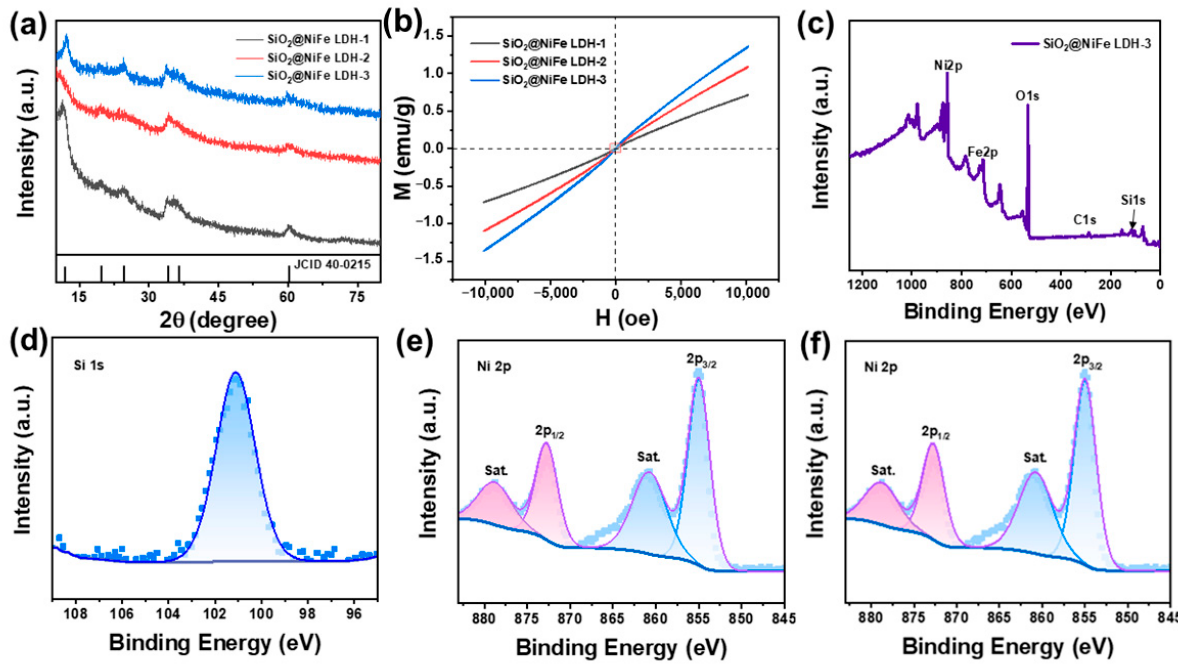
Figure 2. ( a ) XRD patterns, ( b ) magnetic hysteresis loops of SiO 2 @NiFe LDH-1, 2, 3, and ( c – f ) XPS survey spectrum of SiO 2 @NiFe LDH-3: ( c ) total spectra, ( d ) Si 2p, ( e ) Ni 2p, ( f ) Fe 2p. The hysteresis loop (M-H curve) of the SiO 2 @NiFe LDH composites tested under 300 k conditions in the range of − 15 Koe to 15 Koe is shown in Figure 2b. It can be seen that samples with three different molar ratios all exhibit typical weak ferromagnetic proper- ties, that is, the magnetization intensity of the particles changes slightly with the increase of the applied magnetic field, and then reaches a saturation state. The saturation magnet- ization intensity Ms of SiO 2 @NiFe LDH-1,2,3 was 0.75, 1.15, and 1.40 emu/g, respectively. As the molar ratio of Fe 3+ increases, the coercivity of SiO 2 @NiFe LDH composites also gradually increases. Among them, the S3 sample has the greatest coercive force (24.8 Oe). XPS spectroscopy further verifies that the elements Ni, Fe, C, Si, and O in SiO 2 @NiFe- LDH-3 (Figure 2c) conform to HAADF results. The combined energy of 856.5 eV and 874.1 eV is attributed to Ni 2p 3/2 and Ni 2p 1/2 , respectively, representing Ni 2+ in SiO 2 @NiFe-LDH microspheres. Signal sum at 713.3, 726.6 eV corresponds to Fe 2p 3/2 and Fe 2p 1/2 , implying Fe 3+ . XPS surveys of S3 (Figure 2b) showed that the six peaks were located at 857.23, 713.44, 533.7, 285.07, and 102.34 eV for Ni 2p, Fe 2p, O1s, C1s, and Si, where the corresponding atomic concentrations of Ni, Fe, O, C, and Si were 13.54%, 4.07%, 65.65%, 8.60%, and 8.14%, respectively. FT-IR spectroscopy was performed on pure SiO 2 microspheres and SiO 2 @NiFe LDH (Figure S5). The wide peak of pure SiO 2 near 1011.97 cm − 1 is due to the bending vibration of the physical absorption of water, and the weak adsorption peak at around 791 cm − 1 is due to the existence of the Si-O-Si bond. The characteristic peaks of -OH and physical adsorption water still exist at about 3384.77 cm − 1 and 1636.80 cm − 1 of SiO 2 @NiFe LDH. The weak peak near 1007.78 cm − 1 is considered to be the intercalation structure of -OH and CO 3- in hydrotalcite (NiFe LDH). The bending vibration mode of metal hydroxide octahe- dral complexes (Ni-O and Fe-O) is observed at 594.97 cm − 1 and 663.99 cm − 1 , respectively. The results show that NiFe LDH is formed on SiO 2 microspheres, which is consistent with the XRD characterization results. Thermal analysis (Figure S6a–c) shows that SiO 2 @NiFe LDH-1, 2, 3 have two significant mass reduction processes during the temperature rise from 30 °C to 1000 °C. The weight loss of the S3 sample was 5.5635% at about 150 °C and